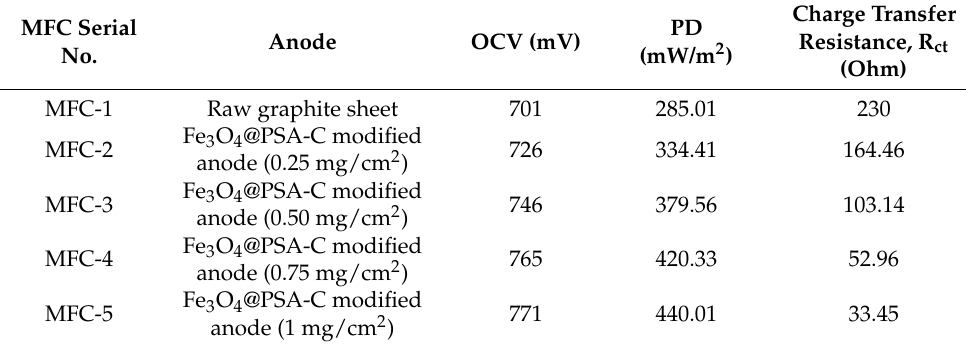
Table 1. Comparison of different quantities of Fe 3 O 4 @PSA-C (0.25, 0.50, 0.75, and 1 mg/cm 2 ) in the anode with the standard graphite